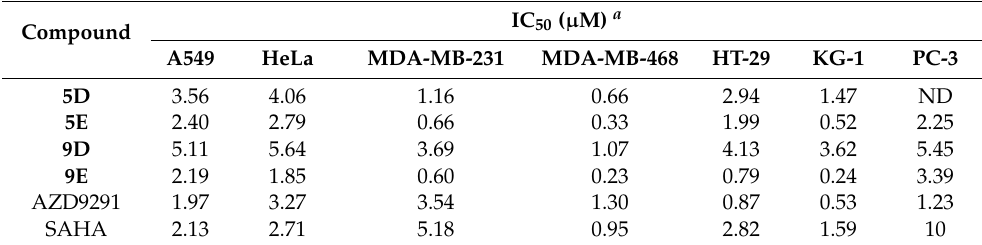
Table 3. In vitro antiproliferation assay.